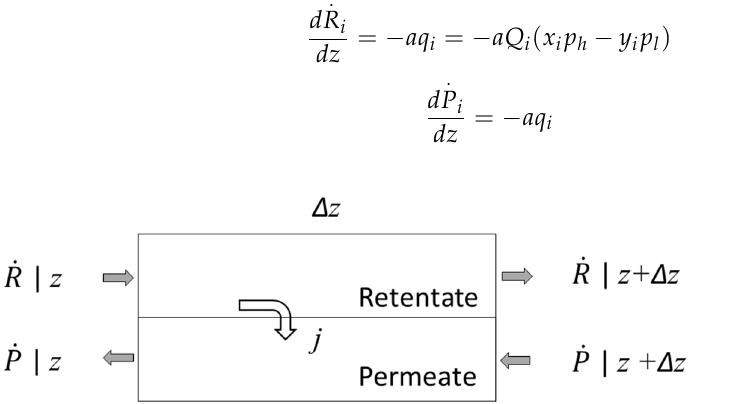
Figure 4. Schematic of ideal counter-current module.